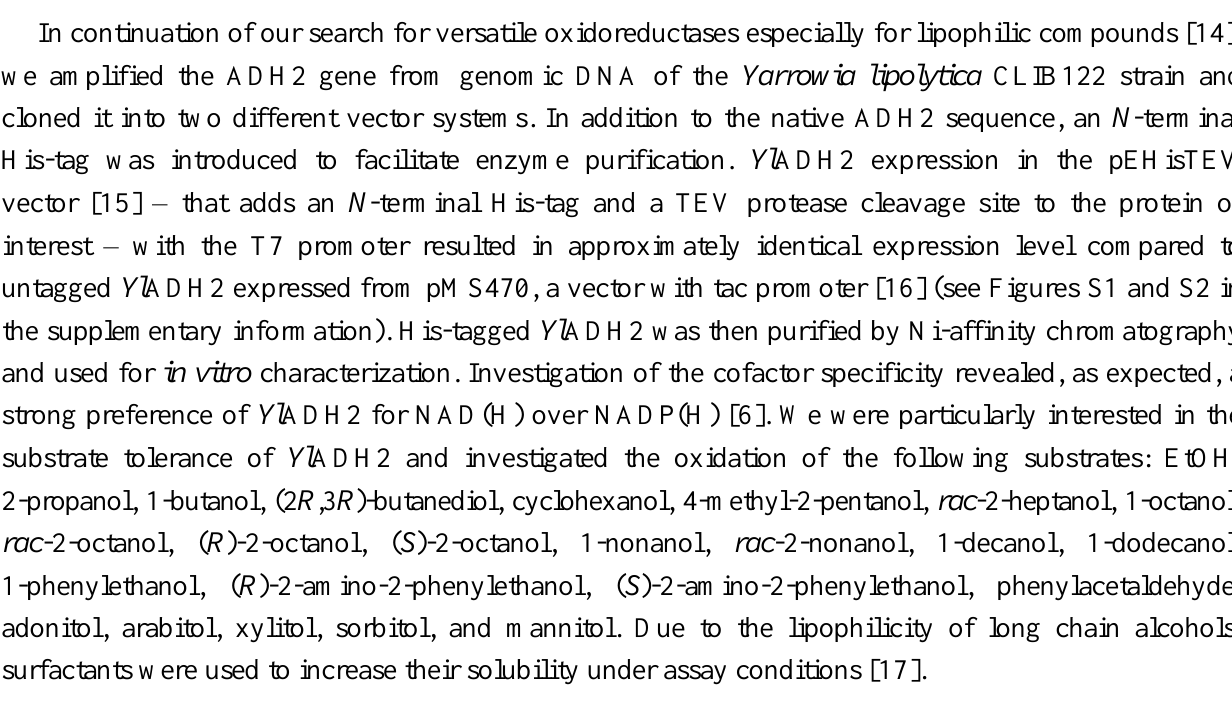
Table 2. Exploration of the substrate spectrum of Yl